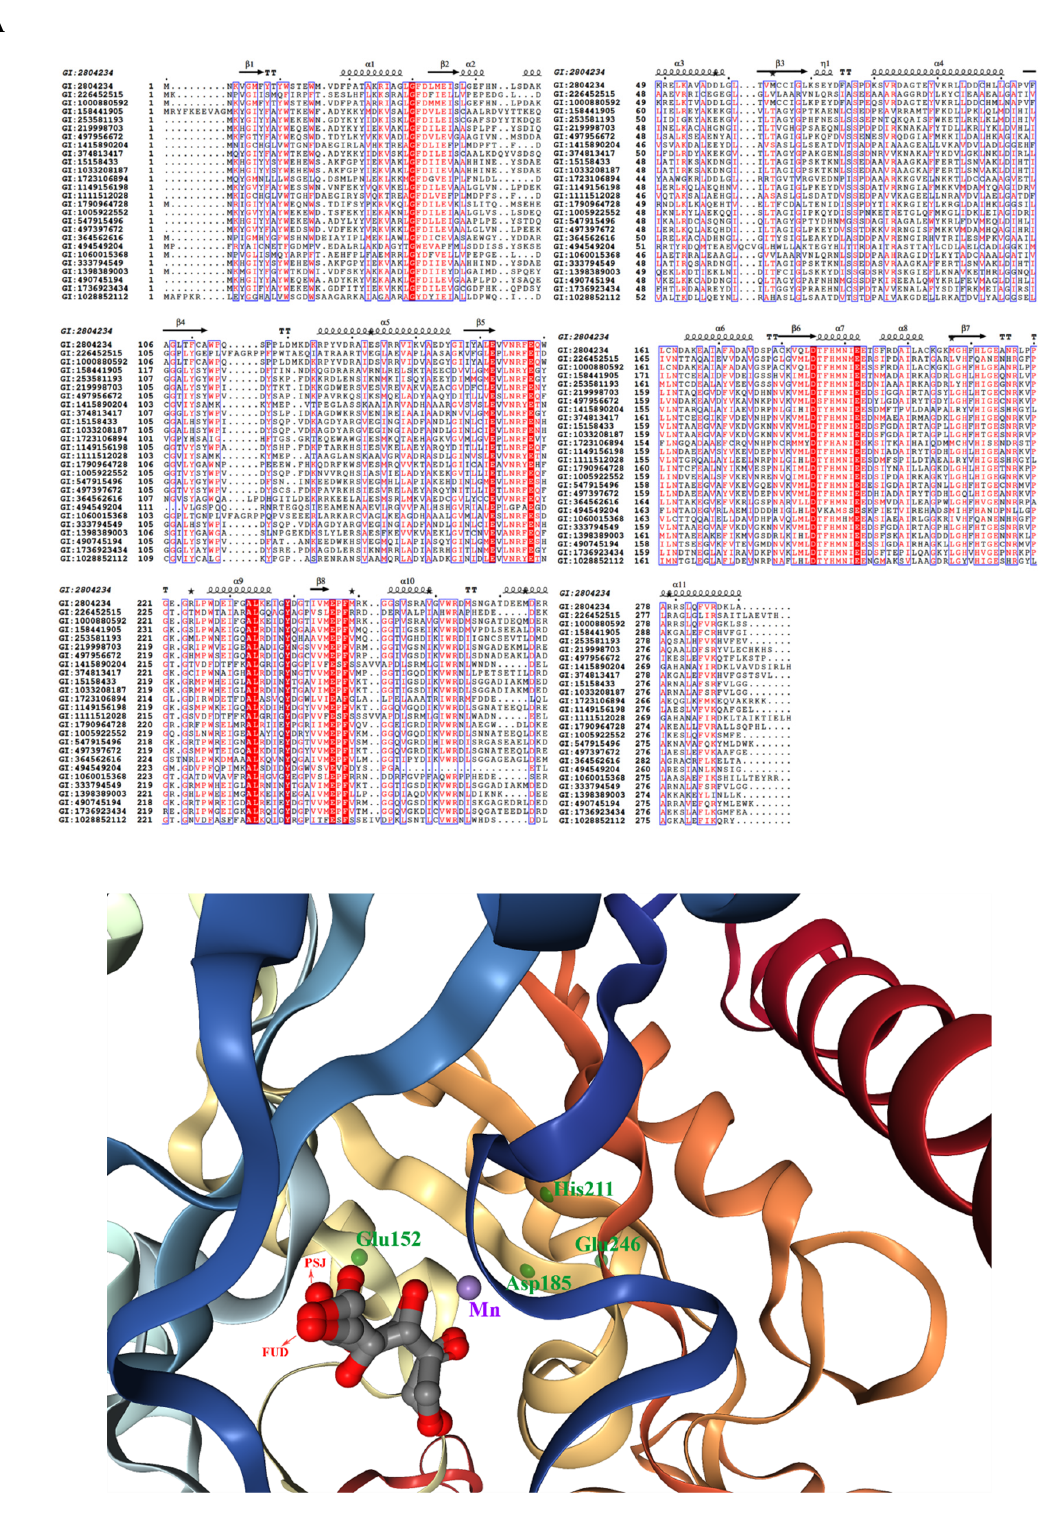
Figure 5. ( A ) Multiple sequence alignment of D -tagatose-3 epimerases and D -allulose-3 epimerases. The red-boxed characters are the strictly identical amino acid residues. ( B ) Superimposition of the crystal structure of PDB:4PFH. The purple ball is the Mn 2+ ion. The green dots are the ligand residues (in Chain B) with interactions with the Mn 2+ ion and the substrate. The substrate D -fructose (FUD) and the product D -psicose (PSJ) are shown with arrows. The figure was visualized with an NGL engine powered by the MMTF program.